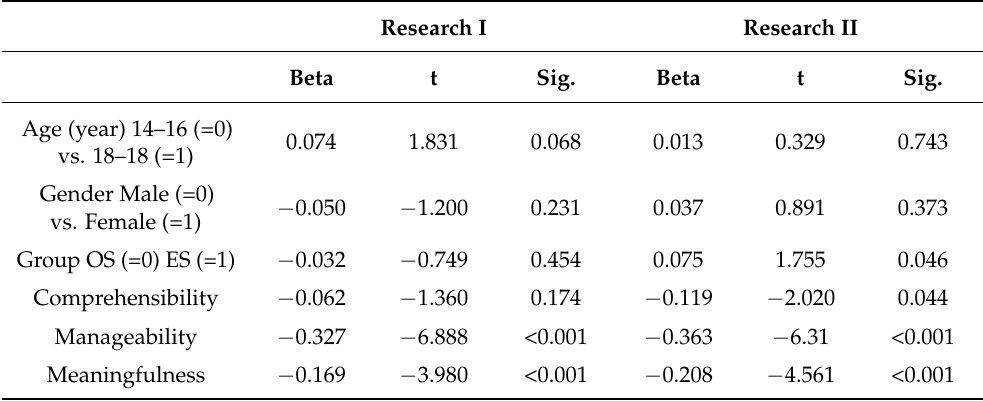
Table 6. Standardized regression coefficients and significance levels of the hypothesized determinants of aggression tested by a multiple linear regression